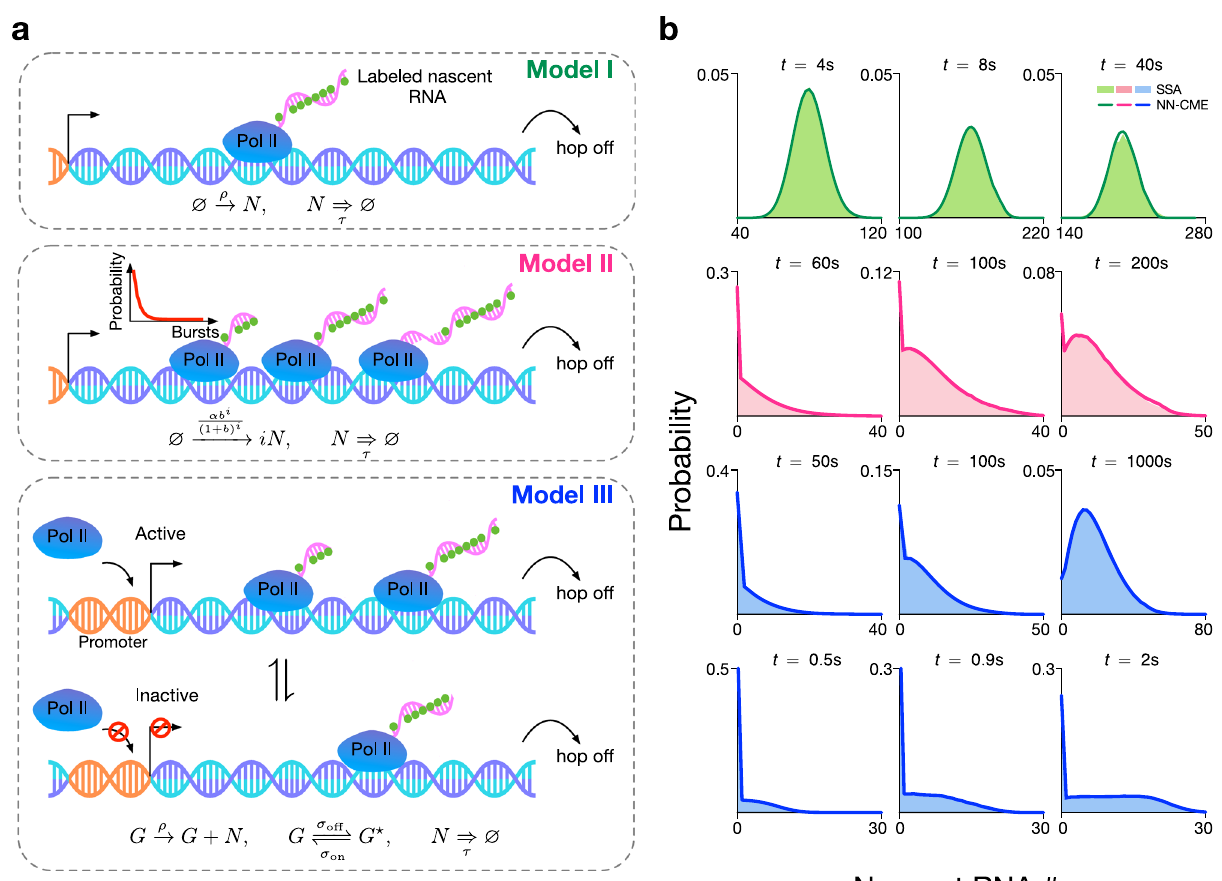
Fig. 2 ANN-aided stochastic model approximation of various models of transcription. a Illustration of three models of transcription. The models describe initiation, elongation and termination and speci fi cally predict the numbers of nascent RNAs (equivalently the number of RNAP polymerases, Pol IIs) at the gene locus. In all models, a nascent RNA molecule detaches after a constant time has elapsed from its binding to the promoter. The models differ in how they model Pol II binding: in Model I, the binding is modelled as a Poisson process, hence one at a time; in Model II, binding occurs in bursts, whose size conforms to a geometric distribution; in Model III, the gene switches between active and inactive states, and only the active state permits Pol II binding. b For all models, the FSP solution of the NN-CME derived by the ANN-aided procedure is in excellent agreement with the SSA of the delay CME. The accuracy is independent of the modality and skewness of the distribution. The rate constants and other parameters related to the ANN ’ s training are speci fi ed in SI Table